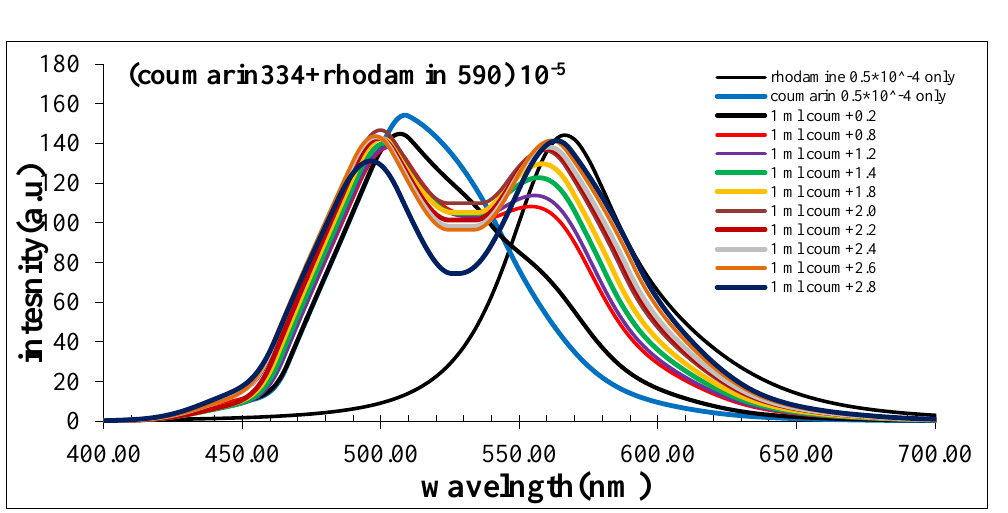
Fig. 7: Energy transfer process between Coumarin 334 and Rhodamin 590 at different